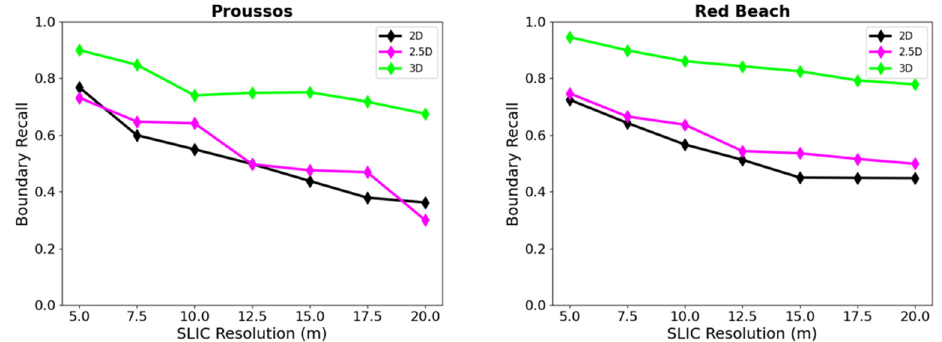
Figure 6. Quantitative over-segmentation performance evaluation based on the boundary recall using SLIC for each dimensionality of the UAV-derived input digital models.